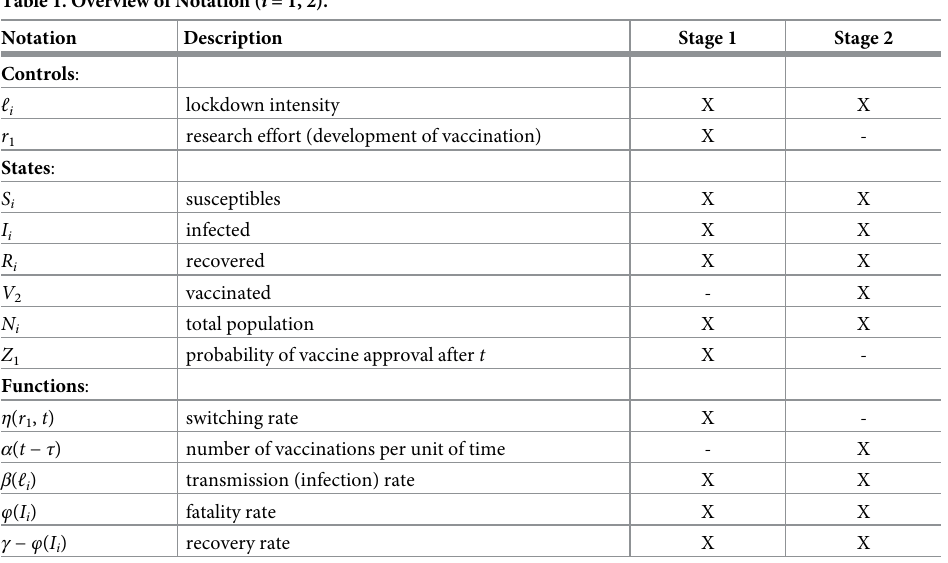
Table 1. Overview of Notation ( i = 1,